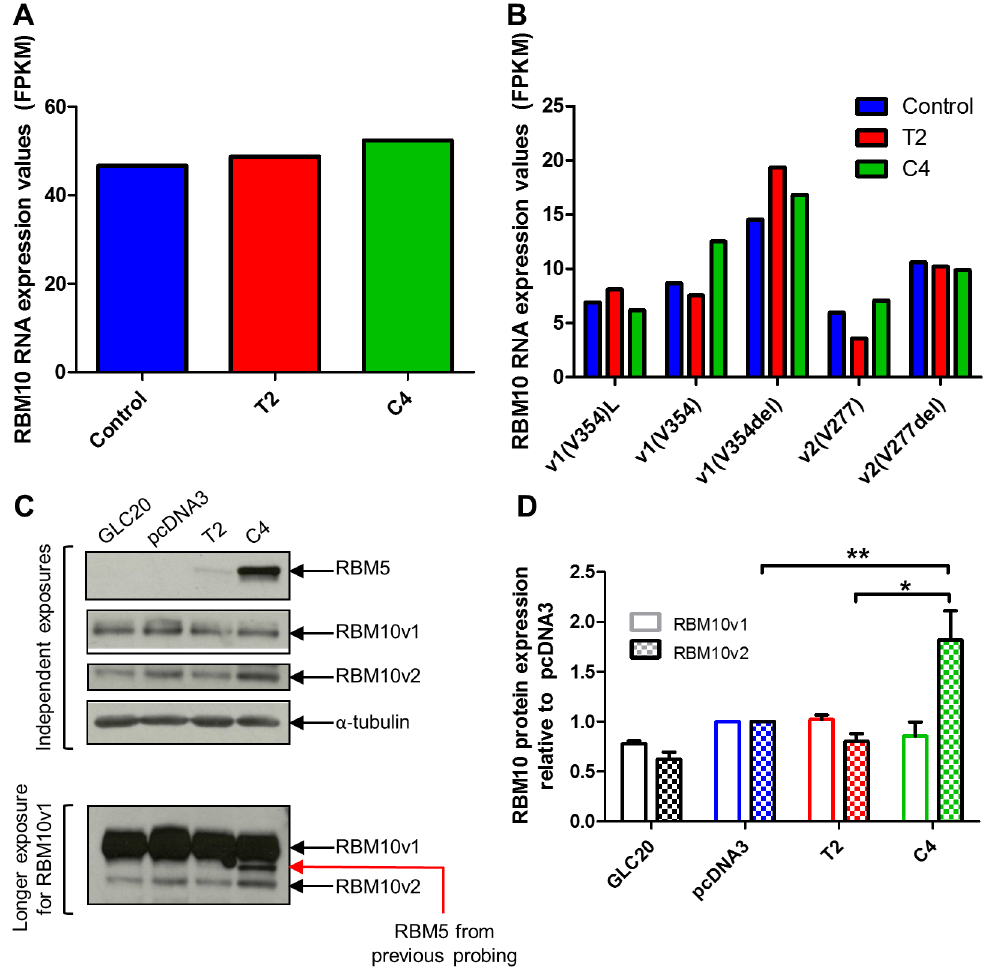
Fig 6. RBM10 expression in the parental GLC20 cell line and stable RBM5 -expressing sublines. (A) Expression of all RBM10 mRNA variants, as determined by RNA-Seq. (B) mRNA expressionof specific RBM10 splice variants, as determined by RNA-Seq. ‘Control’in A and B refers to the GLC20 parentalcell line and stable pcDNA3-transfected GLC20 subline.(C) Representative Western blot for RBM5 and RBM10 (Sigma antibody) protein expressionlevels. Alpha-tubulin was used as loadingcontrol. (D) Densitometric results of the average RBM10v1/v2 expressionof three biologicalreplicateseach performed in technicalduplicate. Analysis was performed using AlphaEaseFC, ‘1D-Multi’analysistool. Values of RBM10v1 and RBM10v2 were normalizedto the α -tubulin of each biological technicalduplicate, and then made relative to the pcDNA3 controls. Standarderror is presented. One-way ANOVA was performed with Tukey post-hoc analysis, betweensublines. * p < 0.05 and ** p <